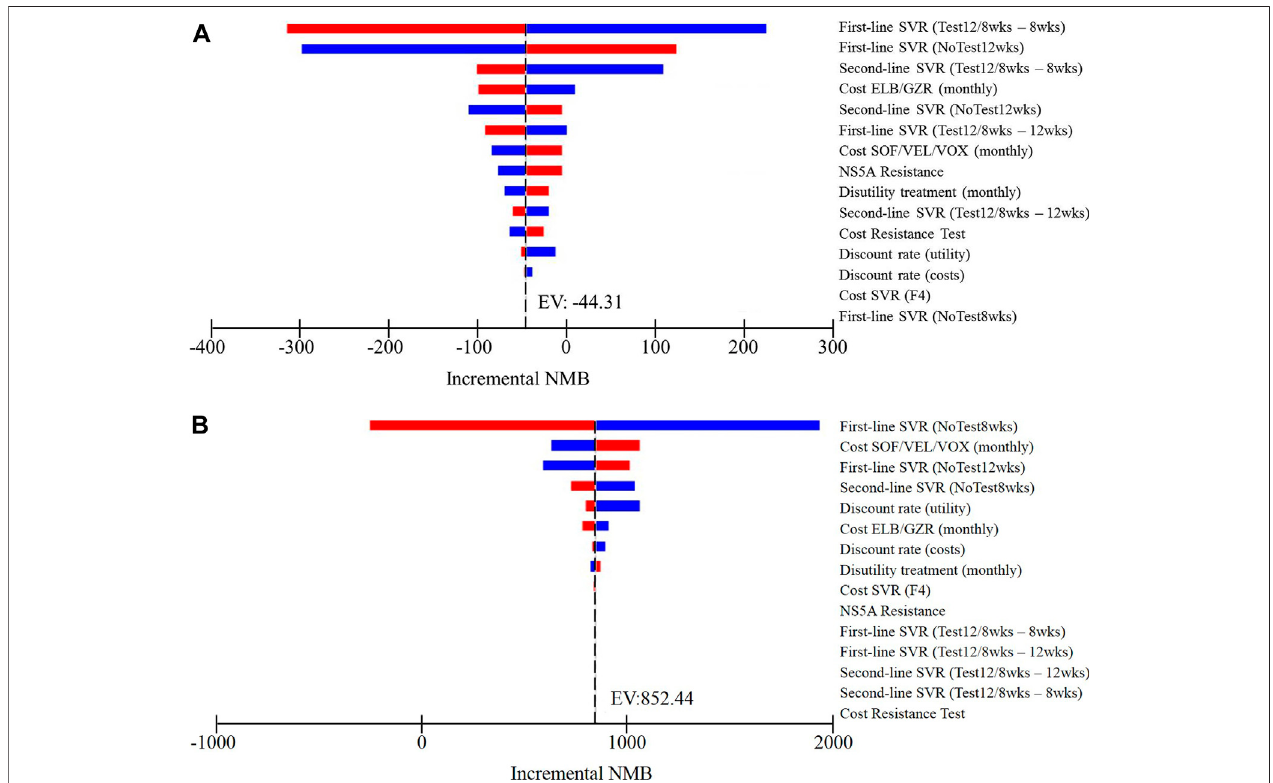
FIGURE 2 | One-way sensitivity analyses show the lower and upper values for the cost-effectiveness ratio of (A) Test 12/8 weeks strategy vs. NoTest 12 weeks strategy and (B) NoTest 8 weeks strategy vs. NoTest 12 weeks strategy for each parameter.